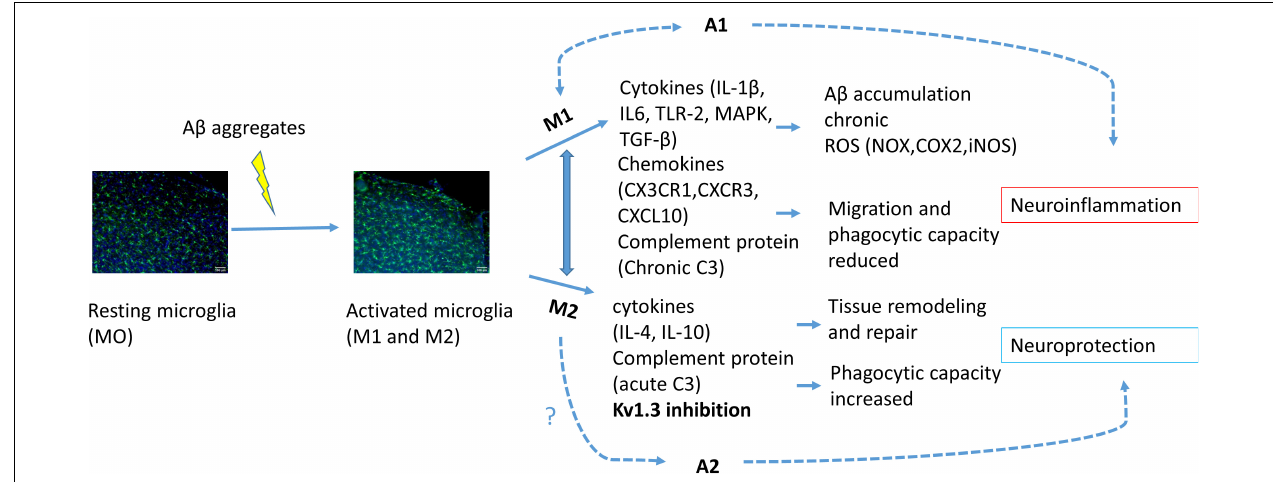
FIGURE 1 | Schematic illustration of microglial activation due to A β accumulation. Activated microglia polarized into M1 or M2 phenotype. Activation of M1 phenotype induces pro-inflammatory cytokine, chemokine and complement protein release provoking citotoxicity and consequently astrocyte A1 activation, neuroinflammation and neuronal cell death. M2 phenotype activation induces anti-inflammatory response and consequently A2 activation and neuroprotection. K V 1.3 inhibition has been related to M2 phenotype